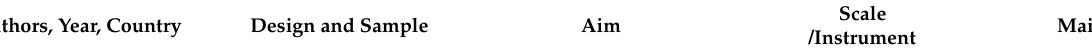
Table 3. Main results